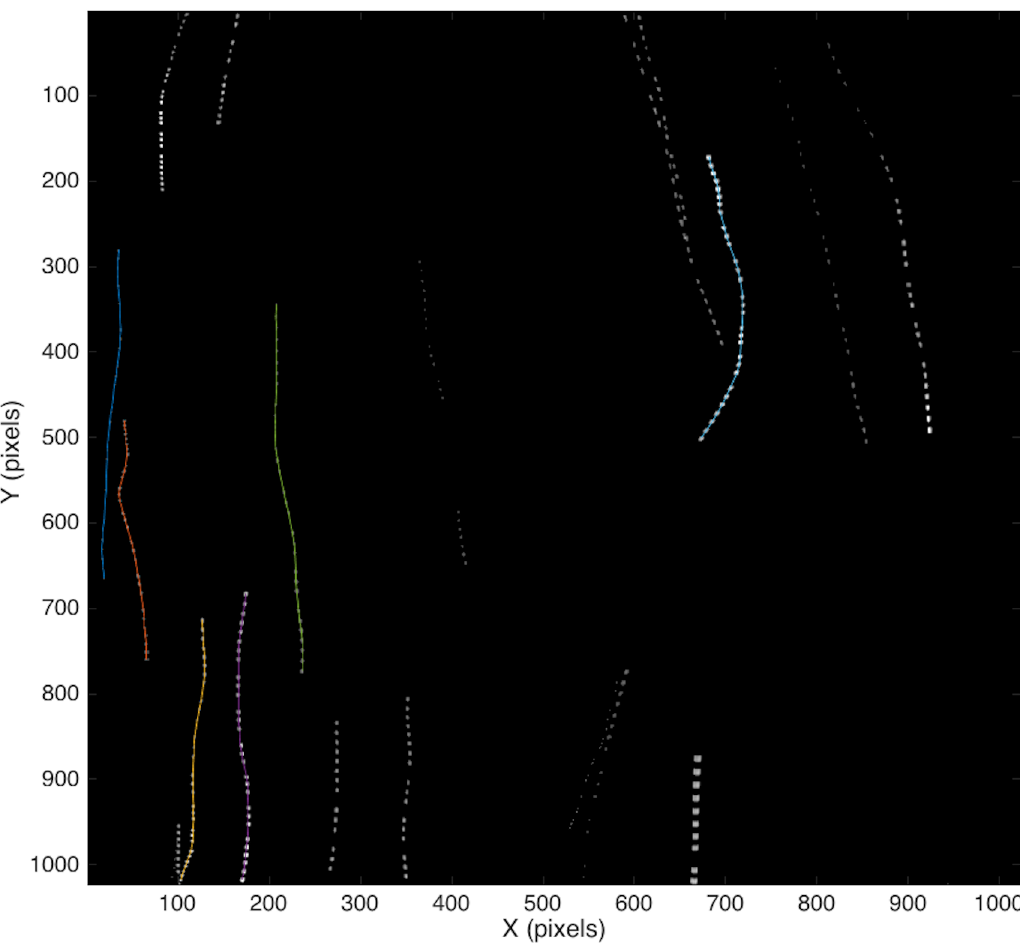
Fig 3. An example of time-lapse trajectories of particles with a 291 μ m mean diameter at 5 Hz grid